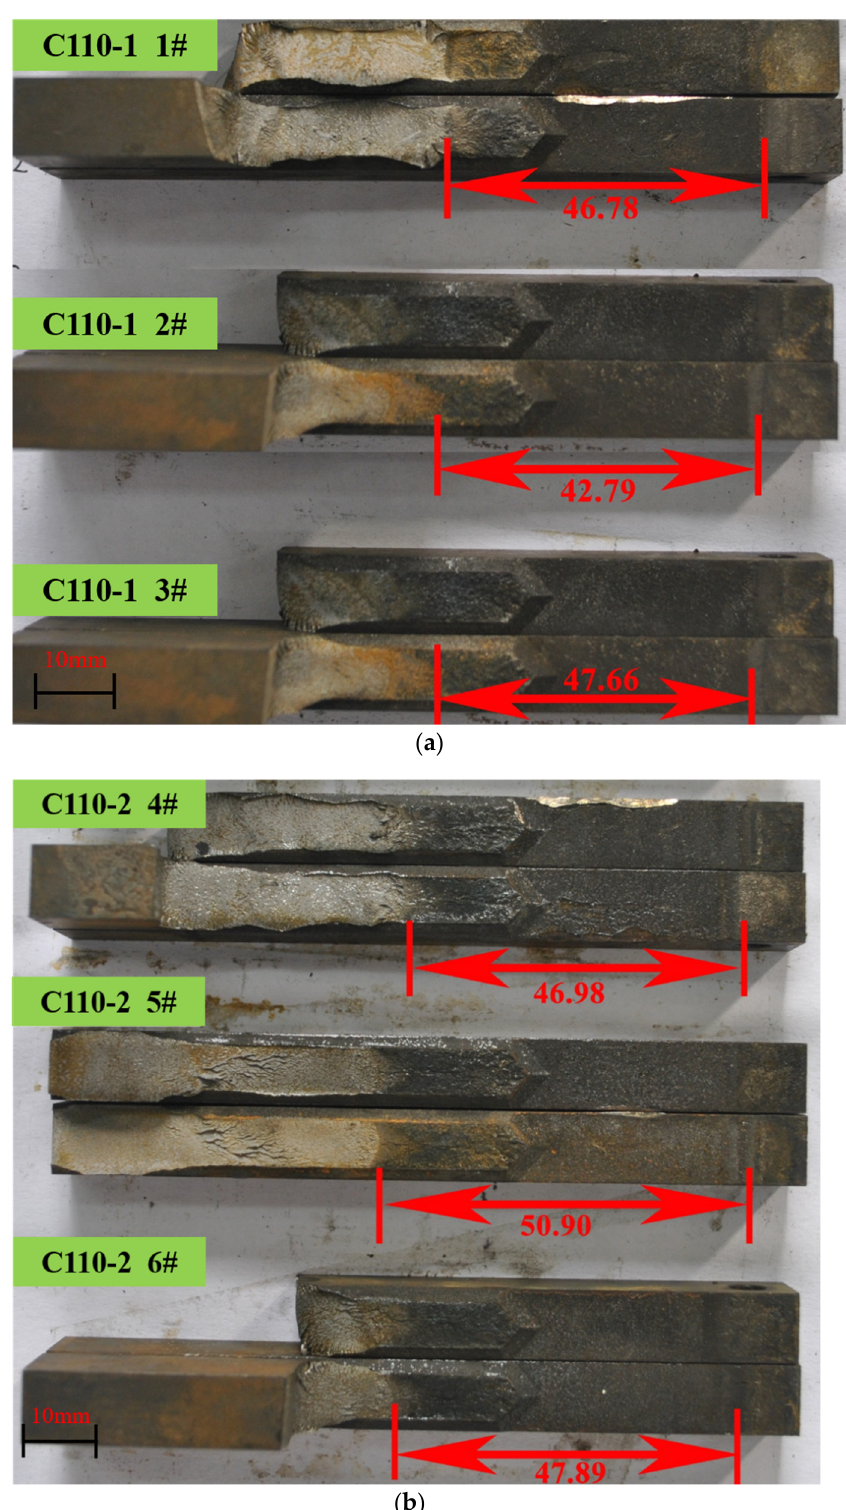
Figure 14. Photographs of samples after quench splitting by liquid nitrogen. ( a ) C110-1 01#, 02#, and 03#. ( b ) C110-2 04#, 05#, and 06#.